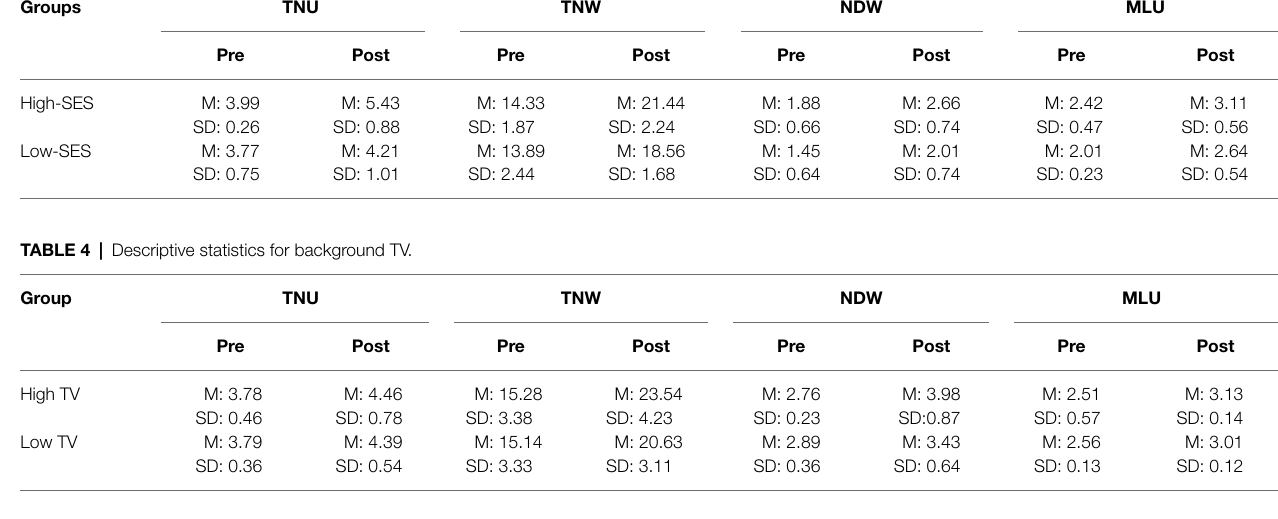
TABLE 3 | Descriptive statistics for the socioeconomic status (SES). Groups